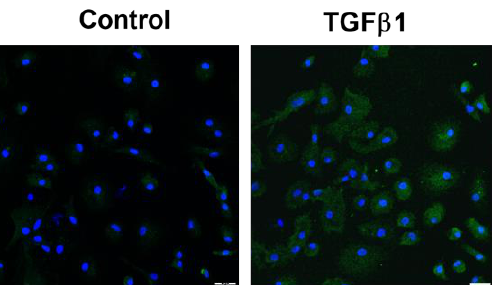
Figure 2. TGF β 1 induced expression of Galectin-3 in human fibrocytes. Fibrocytes were stimulated Figure 2 . TGFβ1 induced expression of Galectin -3 in human fibrocytes. Fibrocytes were stimulated with transforming growth factor β 1 (TGF β 1) 10 ng/mL for 48 h. Representative immunofluorescence with transforming growth factor β1 (TGFβ1) 10 ng /mL for 48 h. Representative immunofluorescence microscope images of control and TGF β 1 10 ng/mL stimulated fibrocytes for GAL-3 immunostaining. microscope images of control and TGFβ1 10 ng /mL stimulated fibrocytes for GAL-3 immunostain- DAPI, blue nuclei. Scale 25 µ m. ing. DAPI, blue nuclei. Scale 25 µm.